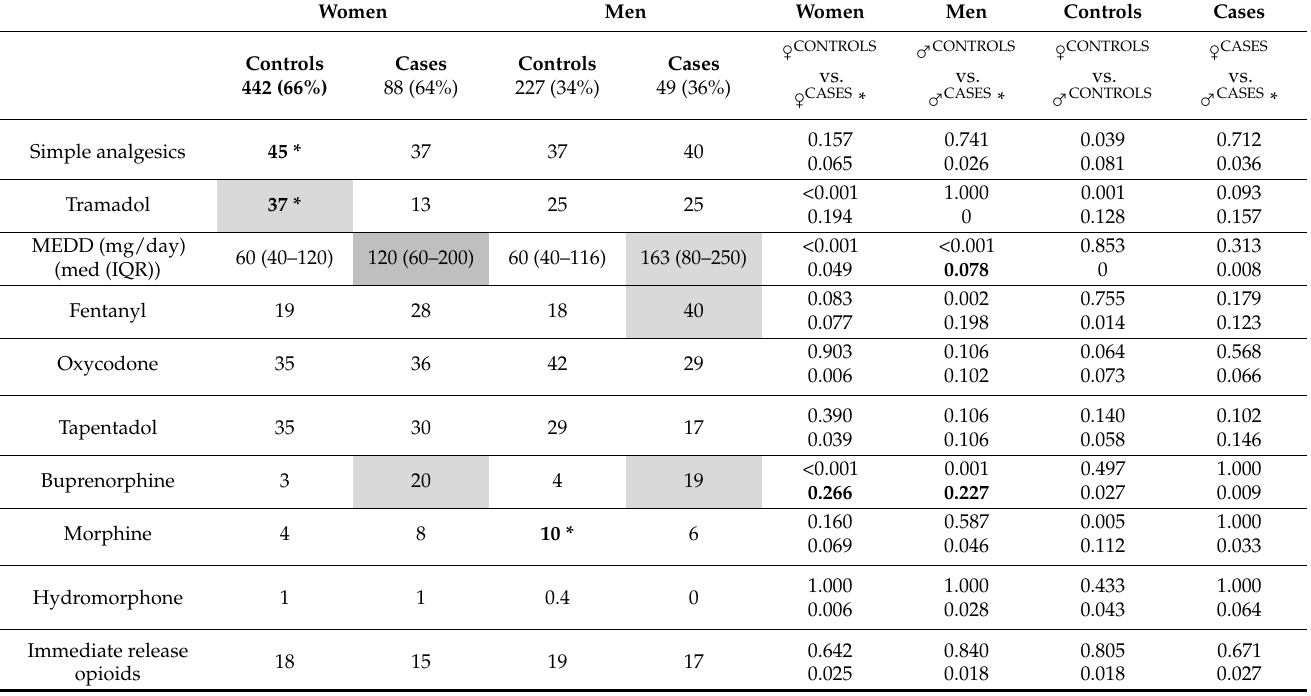
Table 3. Analgesic analysis by sex.